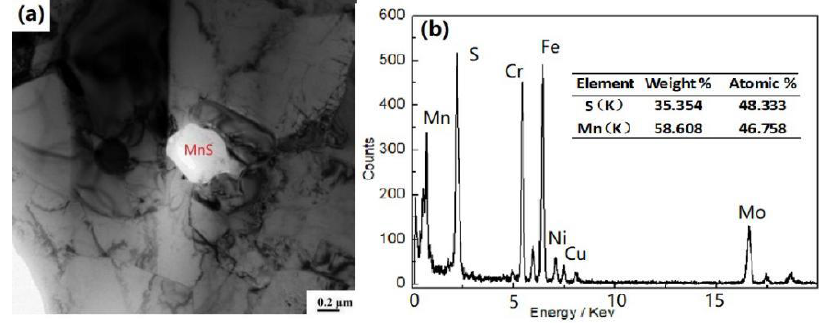
Figure 19. TEM of MnS inclusions: ( a ) shape and ( b ) EDS.